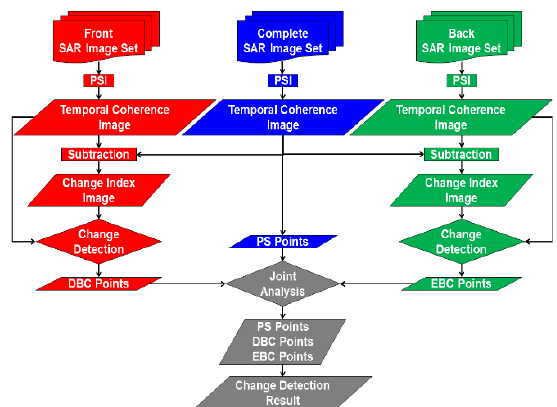
Figure 1. Flowchart of single-break-date change detection. Persistence (blue), disappearance (red), and emergence (green) scenarios are dedicated to extracting PS, DBC, and EBC points,